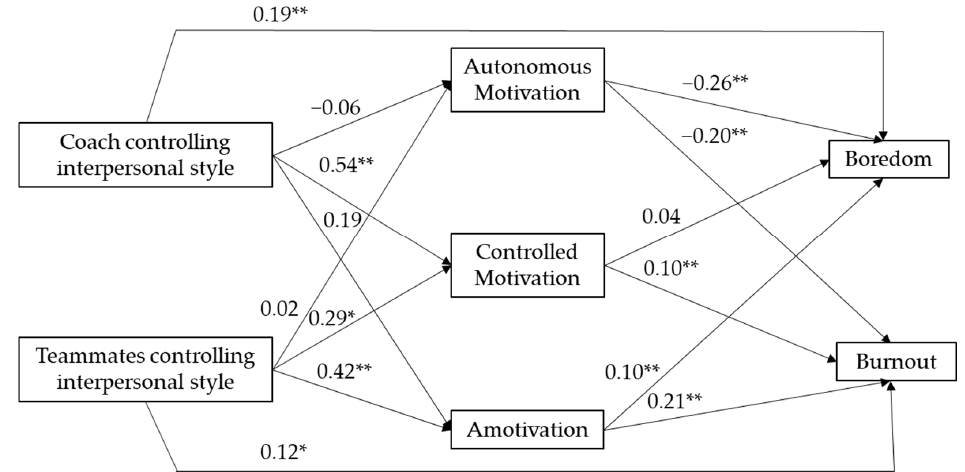
Figure 2. The swimmers’ perceptions of a coach’s controlling style significantly and posi- tively predicted controlled motivation and boredom. Results also indicated that the swim- mers’ perceptions of teammates’ controlling style significantly and positively predicted controlled motivation, amotivation, and burnout. Autonomous motivation negatively pre- dicted boredom and burnout, whereas controlled motivation positively predicted burnout, and amotivation positively predicted boredom and burnout. The indirect effect (IE) of coaches’ controlling style on burnout via controlled motivation was significant (IE = 0.05,